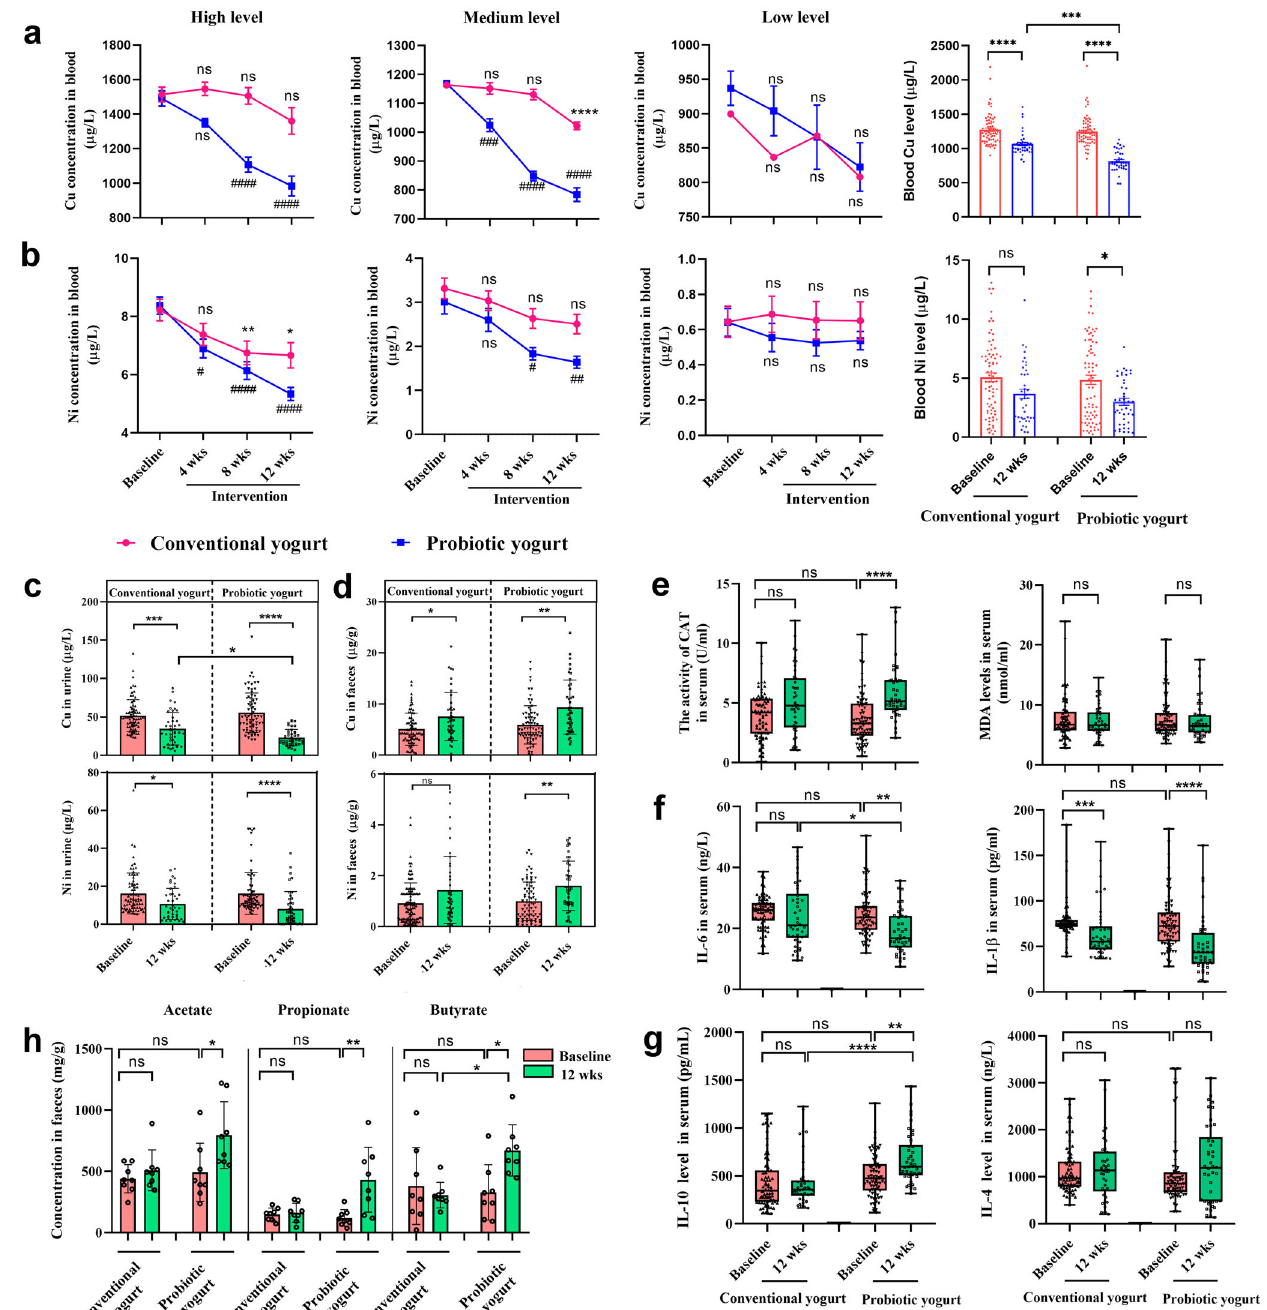
Fig. 2 Probiotic yogurt signi fi cantly decreased heavy metal levels, altered blood biochemical indices, and increased SCFA production in the worker group. Blood Cu ( a ) and Ni ( b ) levels in the high-, medium-, and low-level subsets and total levels of participants in the two groups over the trial period. Changes in urine Cu and Ni levels ( c ) and fecal Cu and Ni ( d ) throughout the trial. Serum CAT activity and MDA level ( e ), IL-6 and IL-1 β levels, and ( f ) IL-10 and IL-4 levels ( g ) of the participants. h Changes in fecal levels of acetate, propionate, and butyrate after yogurt supplementation. For a – d , h , data are expressed as means ± standard errors of the means. SCFAs were expressed as per gram wet feces. For e – g , box limits represent 25 and 75 percentiles; the line within the box indicates median; the whisker represents the minimum and maximum points. a – g baseline ( n = 35) vs. 12 weeks ( n = 42); h n = 8 participants in each group. Statistical analysis was performed using Kruskal – Wallis test with Dunn ’ s post hoc analysis in subgroups. ns, not signi fi cant; * (#), p < 0.05; ** (##), p < 0.01; *** (###), p < 0.001; ****(####), p < 0.0001. a , b * represents signi fi cance in the conventional yogurt group; # represents signi fi cance in the probiotic yogurt group at the same time point. CAT catalase, MDA malonaldehyde, IL interleukin. Source data are provided as a source data fi function was observed after the intervention (Supplementary proin fl ammatory IL-6 and IL-1 β levels (Fig. 2e – g; p CAT < 0.0001, Table 5). Furthermore, the overall metabolic function of the GM of p IL-10 = 0.0066, and p IL-4 = 0.6205; p IL-6 = 0.0011 and p IL- fi cant change in serum MDA levels was all participants was evaluated by measuring the level of short- 1 β < 0.0001). No signi chain fatty acids (SCFAs) in feces (such as acetate, p = 0.0322; detected in either group (Fig. 2e), and normal liver and kidney